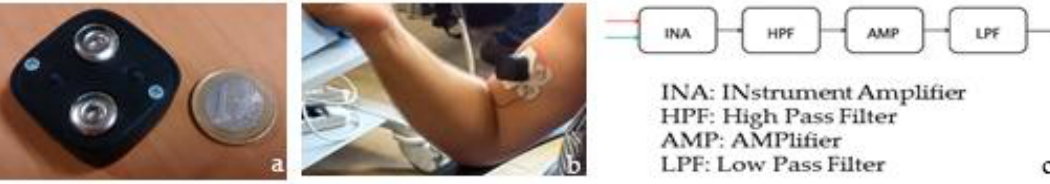
Figure 2. Sketch of the Bio2Bit Move: ( a ) the electrodes; ( b ) case of use; ( c ) blocks for sEMG signal